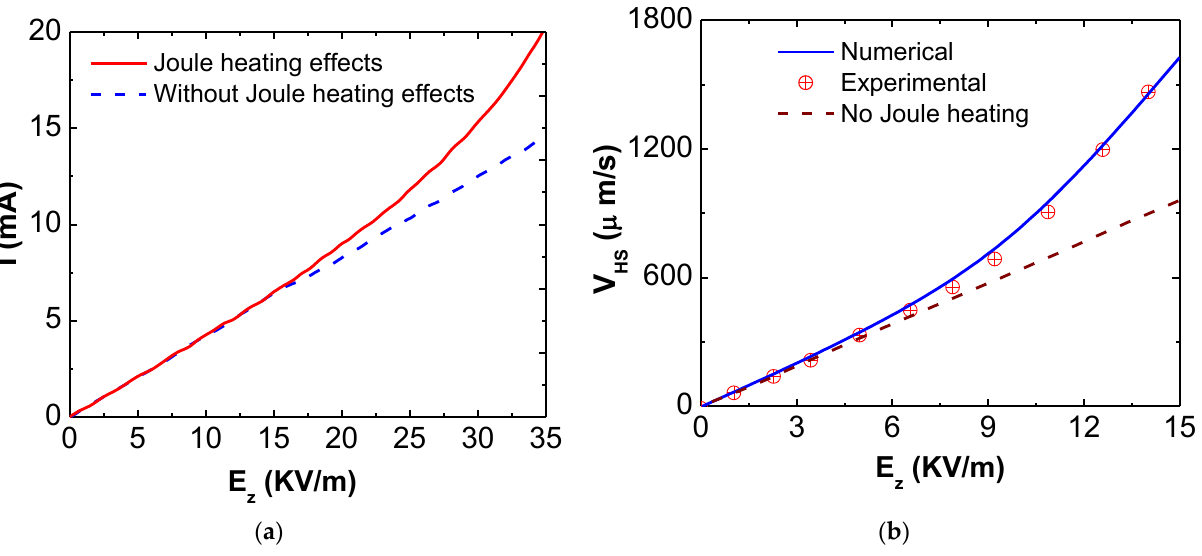
Figure 1. Effects of variation of electric field on electric current and electroosmotic velocity. ( a ) I vs. Electric field E z [109] ( b ) V HS as a function of electric field (E Z ) at 15 s [111]. The Joule heating in the microcapillary amplified is at a high electric field